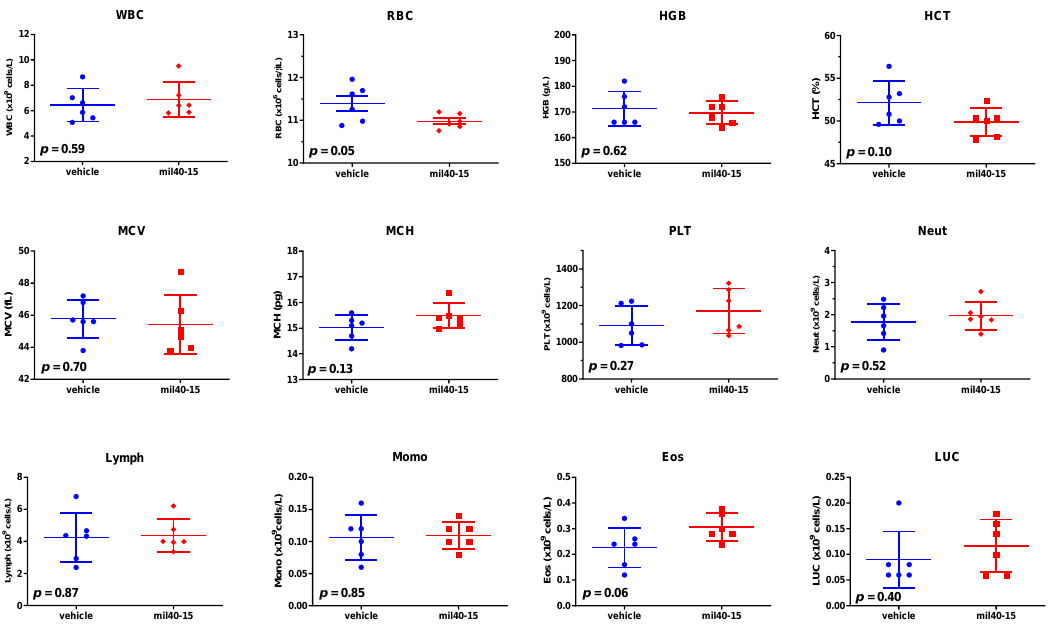
Figure 8. Hematological analysis of the Cys-linker-MMAE-based ADC. The results are shown as the mean ± SD, n = 6 / group. WBCs: white blood cells; RBCs: red blood cells; HGB: hemoglobin; HCT: hematocrit; MCV: mean corpuscular volume; MCH: mean corpuscular hemoglobin; PLT: platelets; Neut: neutrophils; Lymph: lymphocytes; Momo: monocytes; Eos: eosinophils; LUC: large unstained cells.